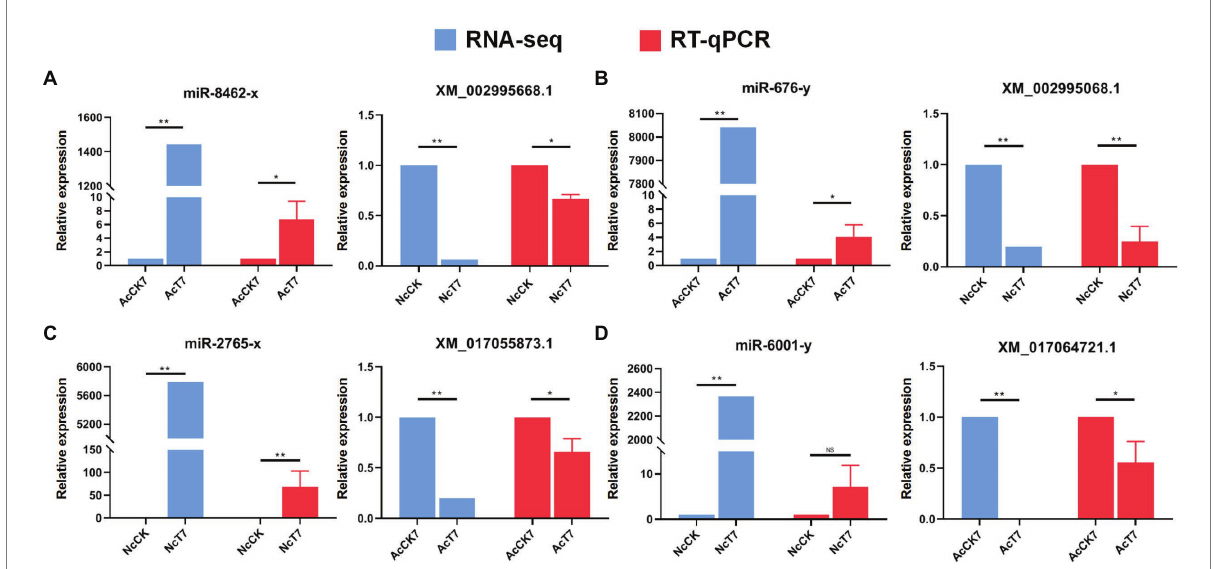
FIGURE 10 RT-qPCR validation of potential host miRNAs-microsporidian mRNAs and microsporidian miRNAs-host mRNAs targeting relationship. (A) RNA-seq and RT-qPCR results of A. c. cerana miR-8,462-x and N. ceranae XM_002995668.1. (B) RNA-seq and RT-qPCR results of A. c. cerana miR-676-y and N. ceranae XM_002995068.1. (C) RNA-seq and RT-qPCR results of N. ceranae miR-2,765-x and A. c. cerana XM_017055873.1. (D) RNA-seq and RT-qPCR results of N. ceranae miR-6,001-y and A. c. cerana